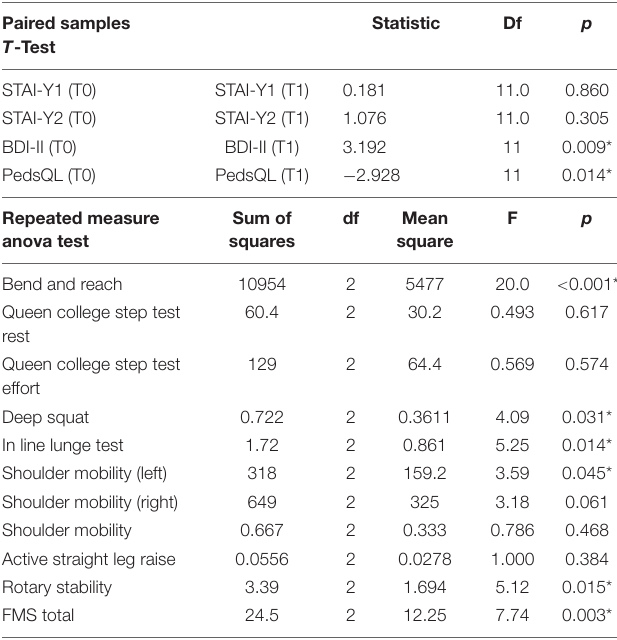
TABLE 2 | Paired samples t -test for psychological measures and repeated measures Anova for motor tests. Paired samples T